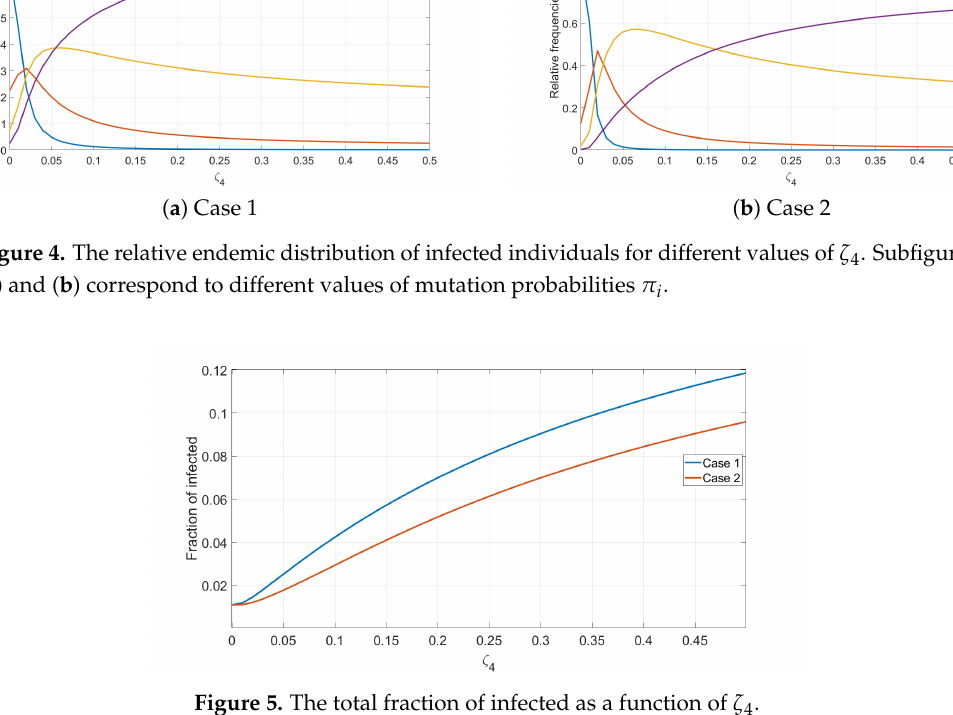
Figure 5. The total fraction of infected as a function of ζ 4